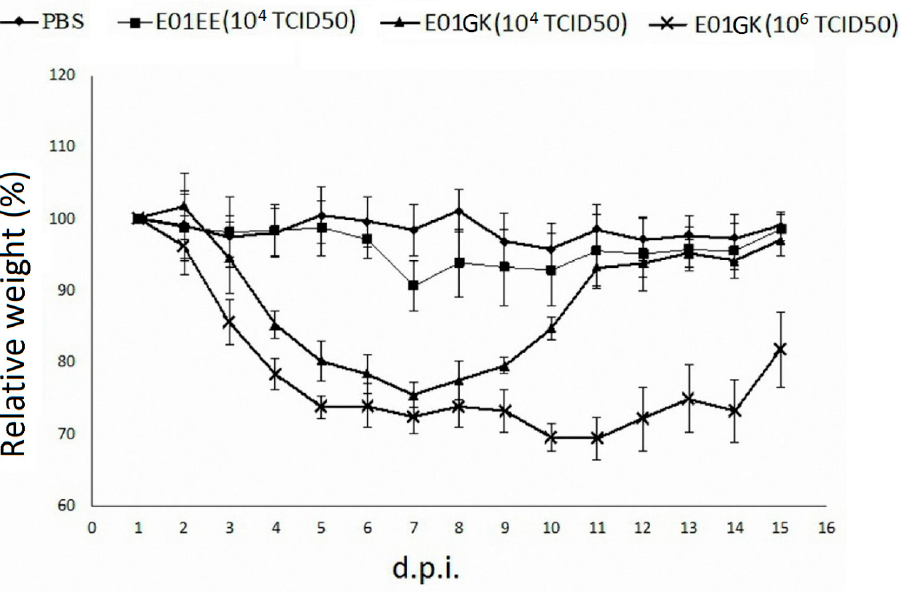
Figure 5. The body weight changes in mice. The values represent the average body weights compared to the baseline weight ± standard deviations from the mice in the same group. Mice were inoculated intranasally with 10 4 TCID 50 / mL of E01EE, 10 4 TCID 50 / mL of E01GK, 10 6 TCID 50 / mL of E01GK or PBS in a 50 µ L volume (25 µ L per nostril). d.p.i.: days post inoculation.